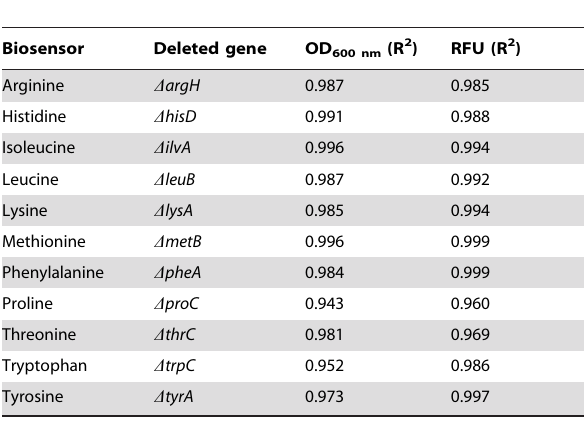
Table 2. Coefficients of determination (R 2 ) of calibration curves generated from amino acid-dependent growth of the different amino acid biosensors tested.